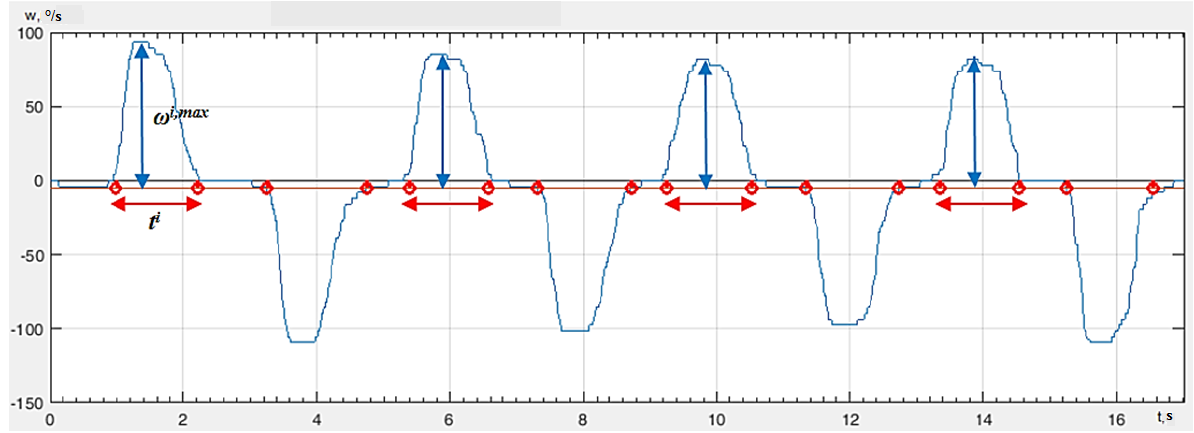
Figure 11 . The example of stability estimation of sub-squat phase biomechanical